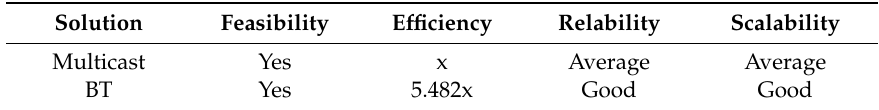
Table 6. Summary of comparisons of characteristics of multicast and BT-based solutions in massive bare-metal